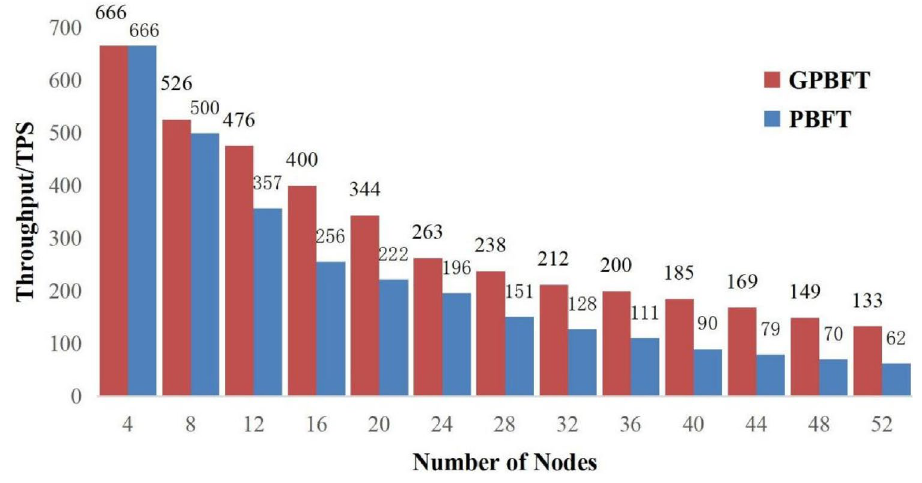
Figure 7. Throughput